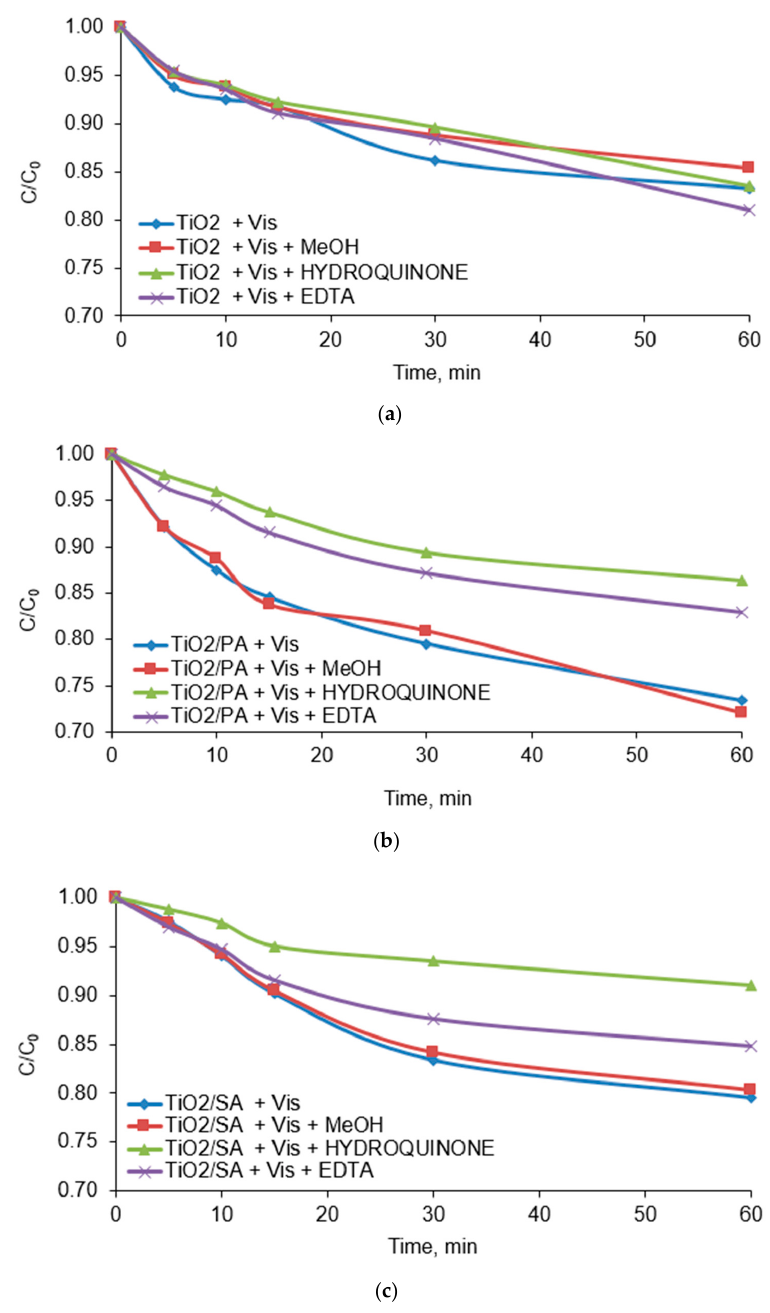
Figure 11. Photodegradation of the CFVP catalysed by ( a ) TiO 2 , ( b ) TiO 2 /PA/90:10 and ( c ) TiO 2 /SA/90:10 in the presence of radical scavengers. Conditions of experiment: C 0 = 1.0 mg/L; D c = 50.0 mg/L; V r = 500.0 mL; pH = 6.0; min; t ir = 60.0 min, D scav. = 50.0 µM. Table 7. Effect of radical scavengers on photodegradation kinetics.